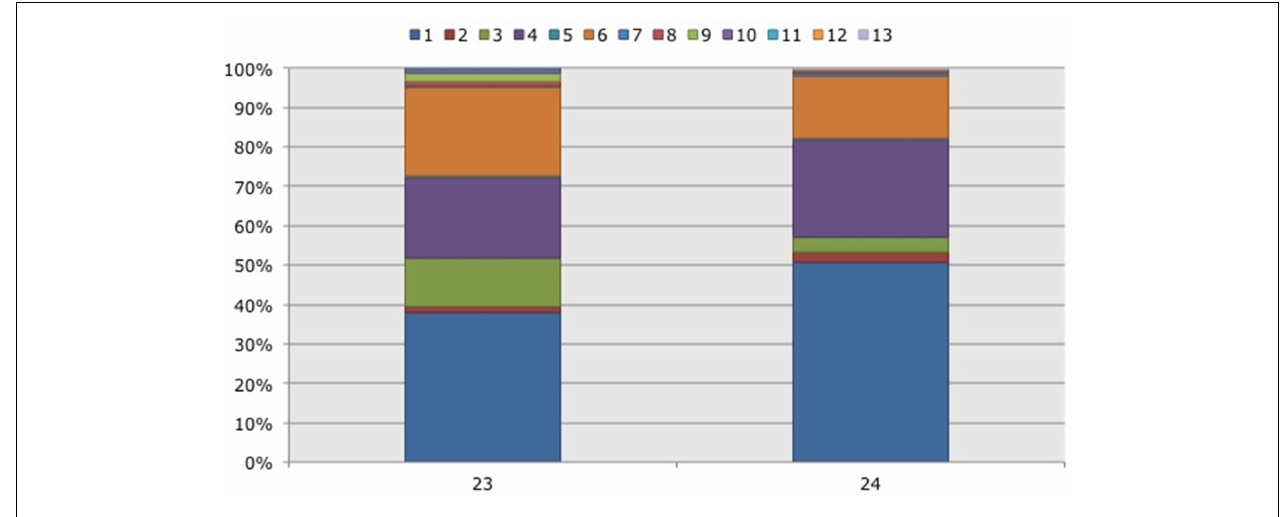
rotationally flooded (number 24) Black mangrove-dominated impoundments in the Indian River Lagoon, Florida. Different colors indicate different OTUs.